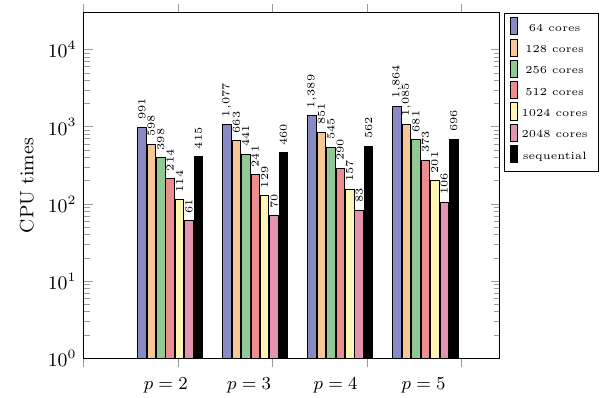
Fig. 8 Strong scalability study for MGRIT using V-cycles and back- ward Euler on the unit square. Here p -multigrid is used for all spa- tial solves within MGRIT 1 https:// useri nfo. surfs ara. nl/ syste ms/